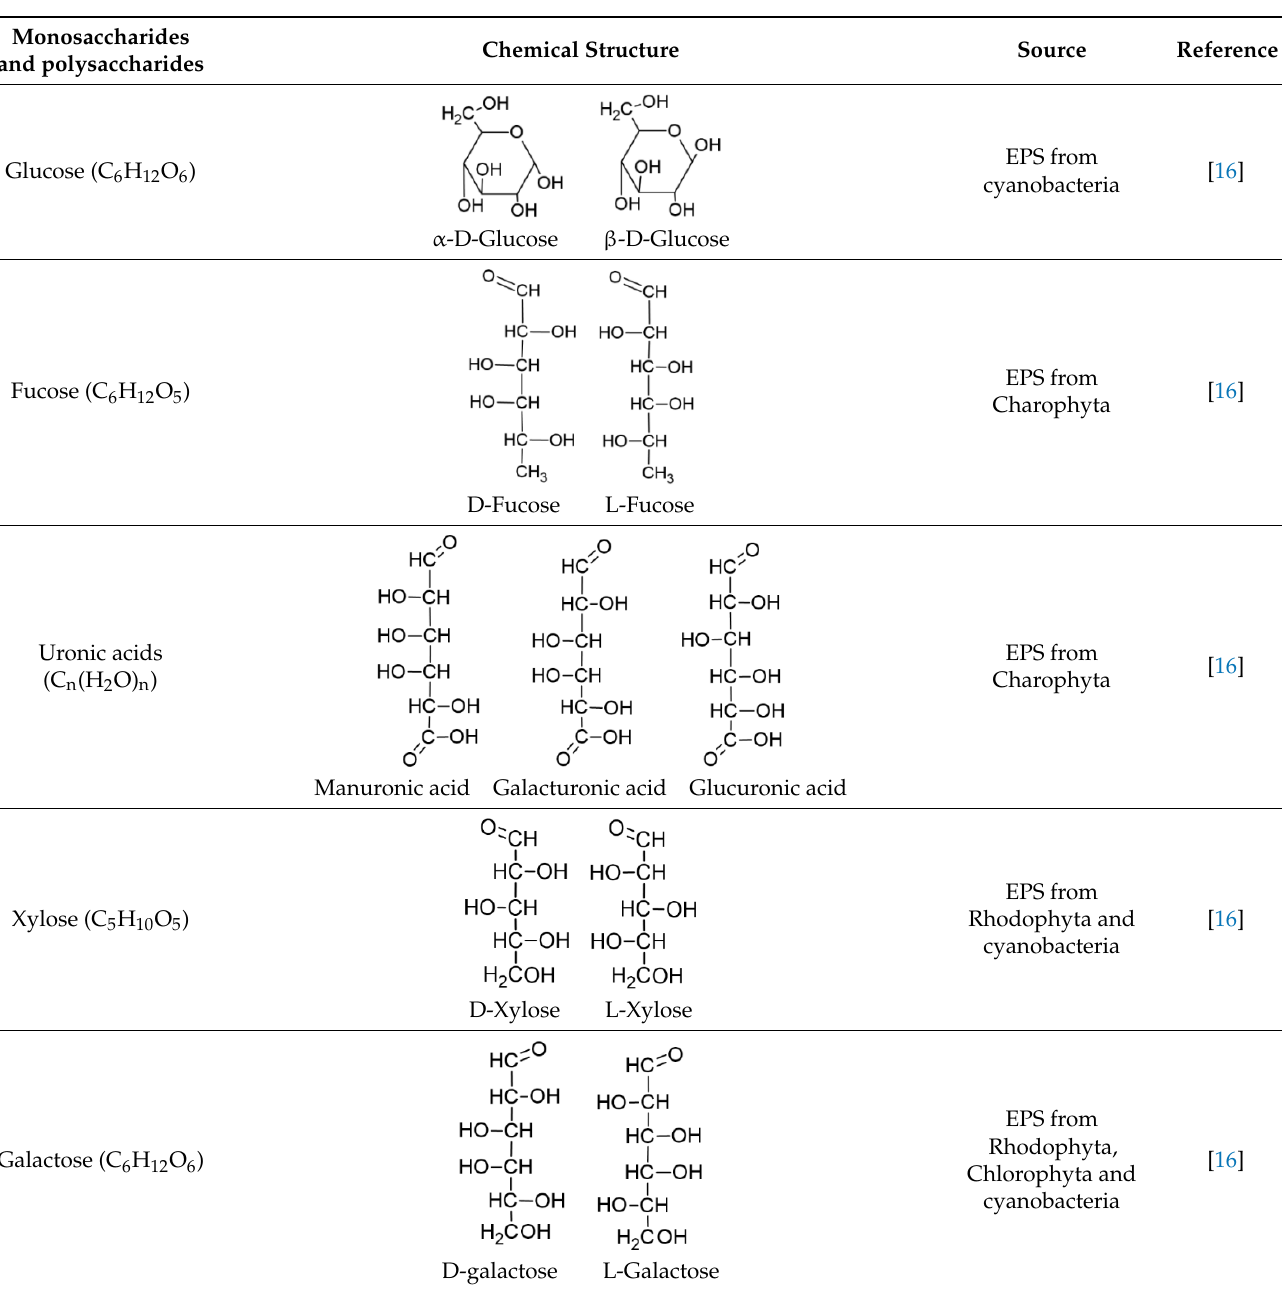
Table 1. Chemical structure of monosaccharides and polysaccharides from different species of microalgae.